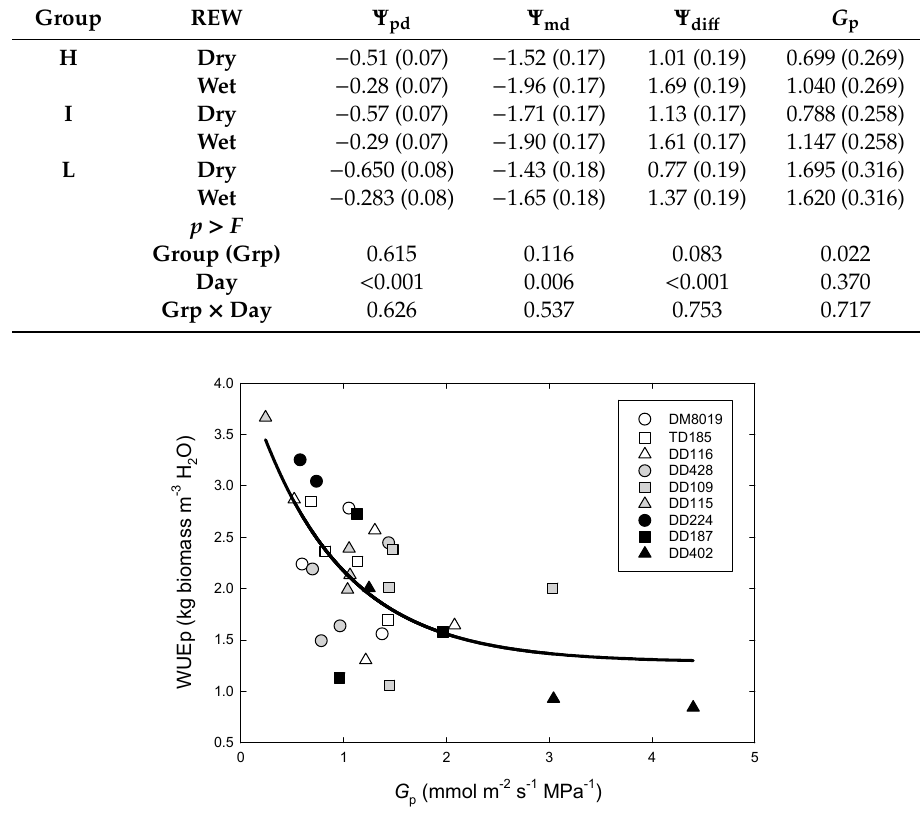
Figure 8. Water use efficiency of production (WUEp) as a function of whole-tree hydraulic conductance ( G p ) in P. deltoides (DD), P. trichocarpa x deltoides (TD), and P. deltoides x maximowiczii (DM) clones. Open symbols, light shaded symbols, and dark shaded symbols, represent high (Group H), intermediate (Group I), and low (Group L) productivity genotypes, respectively.